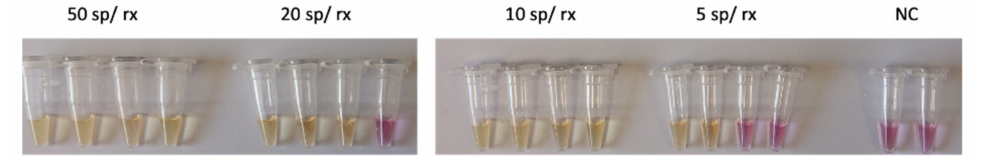
Figure 5. Representative colorimetric LAMP results for C. tyrobutyricum spore detection in milk samples. NC: negative control. All experiments were performed in quadruplicate, each being repeated at least three